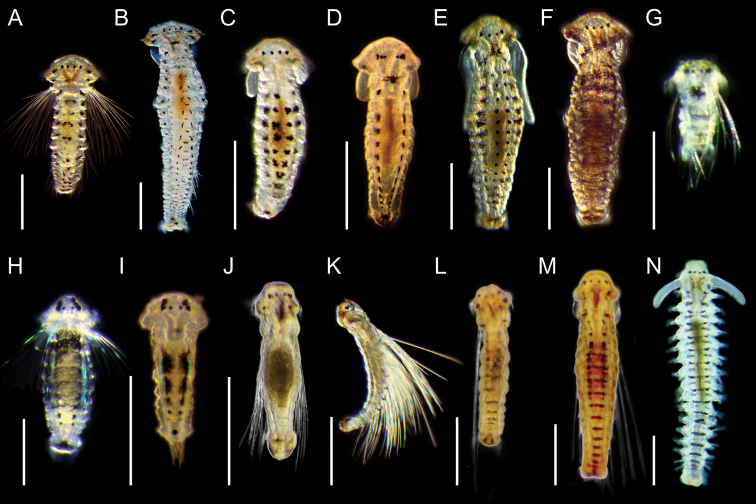
Light micrographs showing the morphologies of living spionid larvae of genera Pseudopolydora and SpioA, BPseudopolydora
aff.
achaeta, dorsal view of 12‐chaetiger (A) and 25‐chetiger larvae (B) CPseudopolydora
cf.
kempi, dorsolateral view of 12‐chetiger larva DPseudopolydora
paucibranchiata, dorsal view of 13‐chaetiger larva E, FPseudopolydora
cf.
reticulata, dorsal view of 17‐chaetiger (E) and 16‐chaetiger larvae (F) G, HPseudopolydora
tsubaki, dorsal view of 5‐chaetiger (G) and 11‐chaetiger larvae (H) IPseudopolydora sp., dorsal view of 7‐chaetiger larva J, KSpio sp. 1, dorsal view of 8‐chaetiger (J) and lateral view of 12‐chaetiger larvae (K) L–NSpio sp. 2, dorsal view of 10‐chaetiger (L) and 17‐chaetiger larvae (M), and 17‐chaetiger metamorphosing larvae (N). Scale bars: 300 μm.